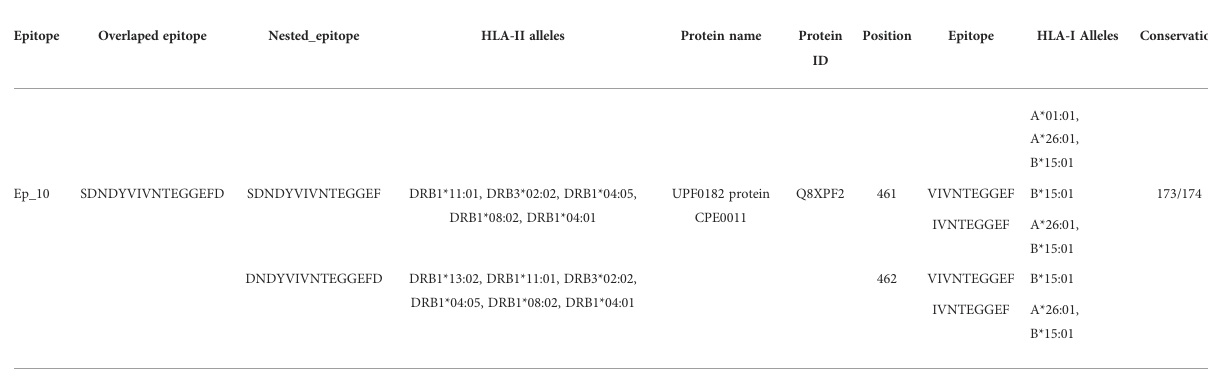
Table 6). Using BLASTp, we obtained that only a 5 aa fragment of an epitope (DTNYI) matched with a human protein (ATP-